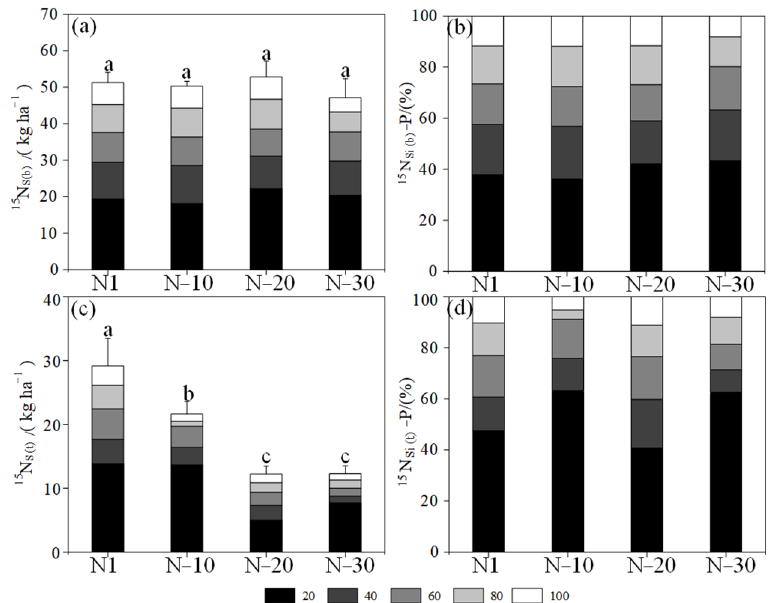
Figure 4. Nitrogen residues from the basal fertilizer and topdressing fertilizer in the 0–100 cm soil layer ( a , c ) and the proportion of residues in each soil layer relative to the total residues in the 0–20 cm, 20–40 cm, 40–60 cm and 80–100 cm soil layer ( b , d ). Note: different letters indicate significant differences ( p < 0.05). N0, N1, N − 10, N − 20 and N − 30 represent the five fertilization treatments.